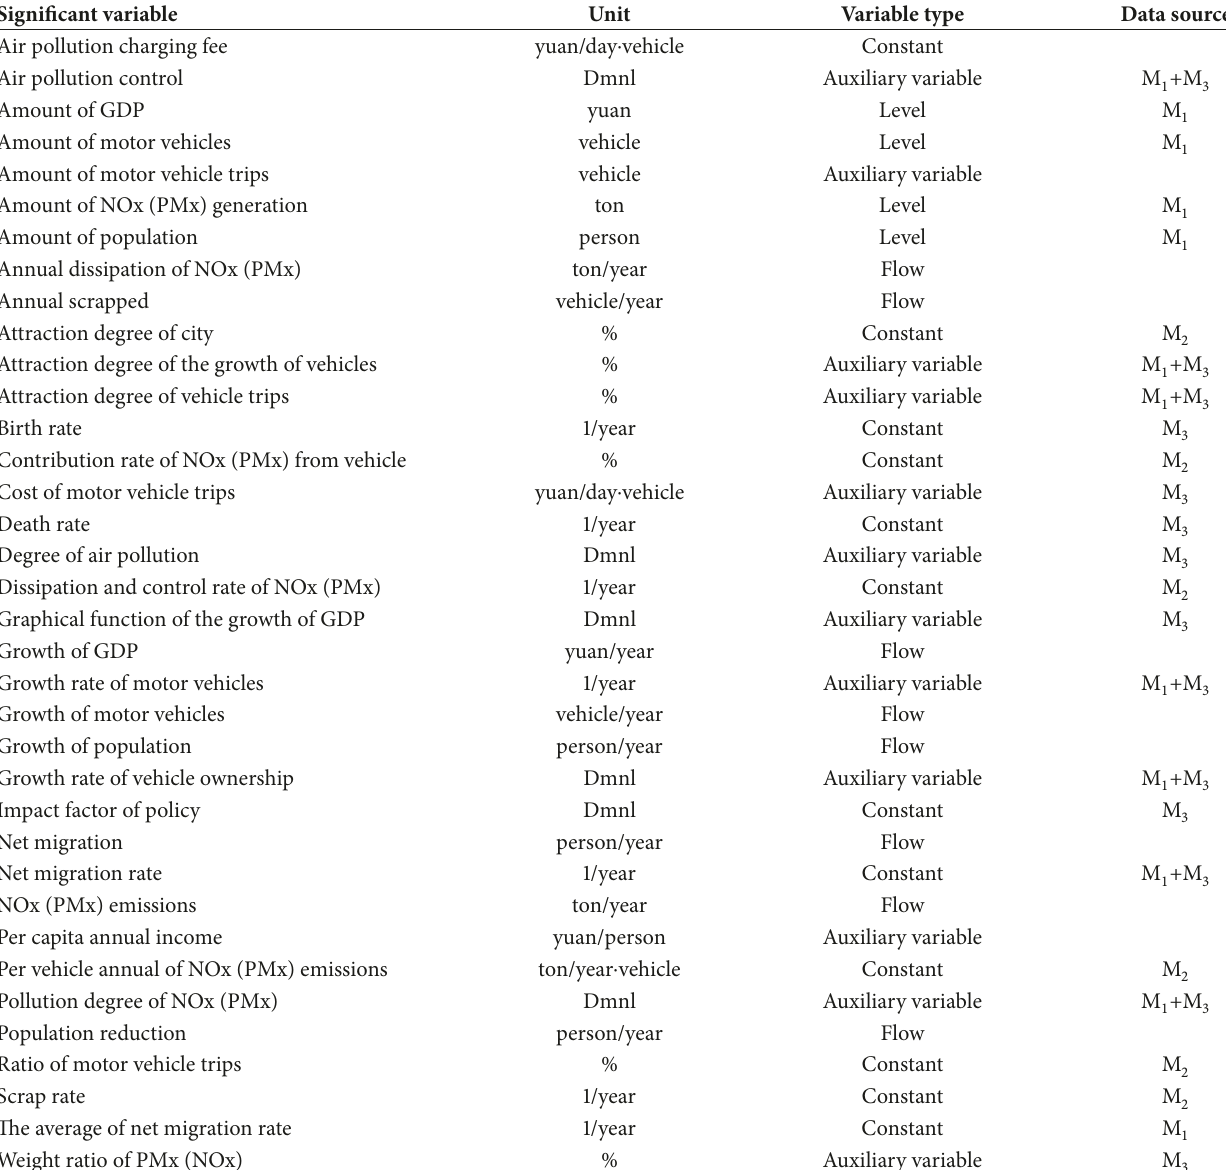
Table 11: Description of main variables in stock flow